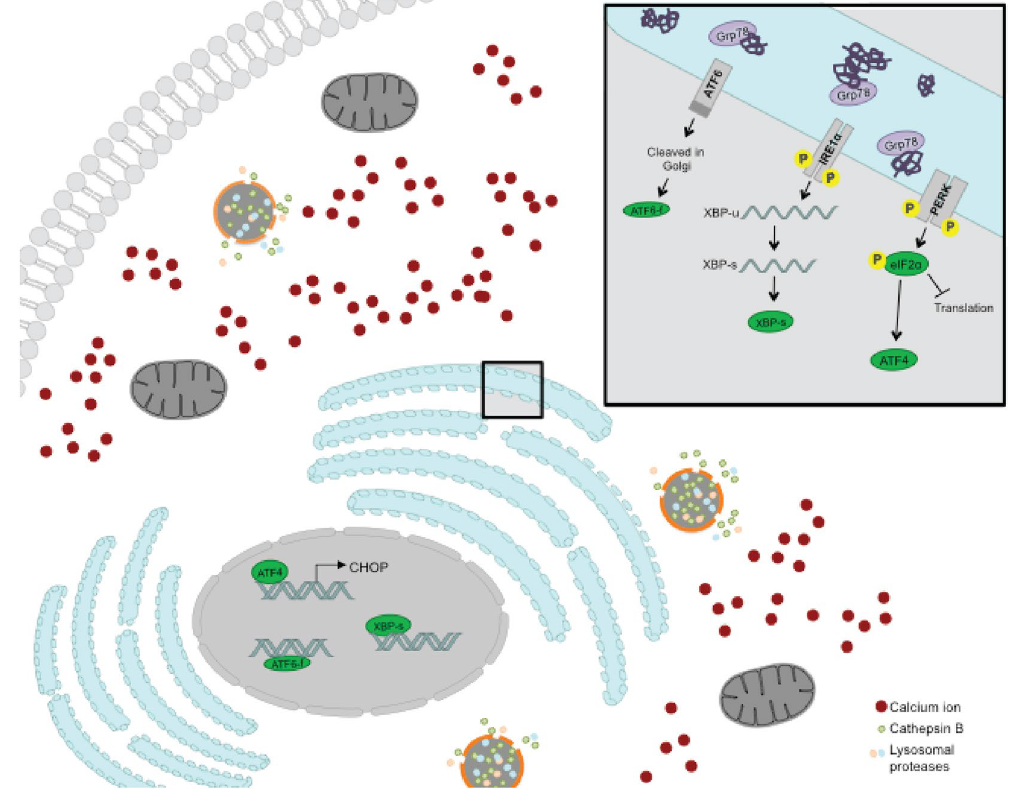
Figure 5. Schematic diagram showing how Sp1 downregulation prevents ER